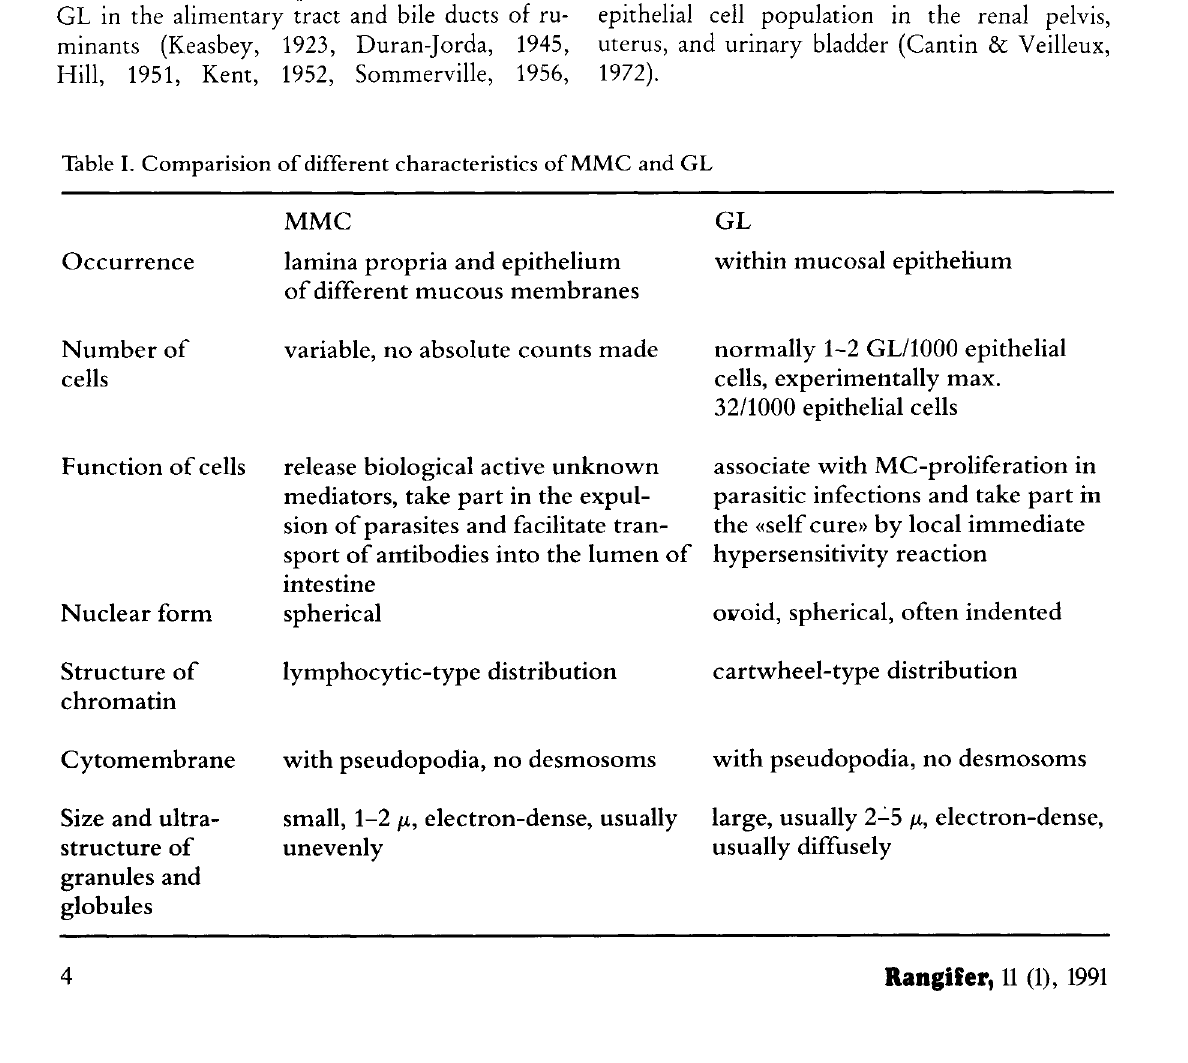
Table I. Comparision of different characteristics of M MC and GL M